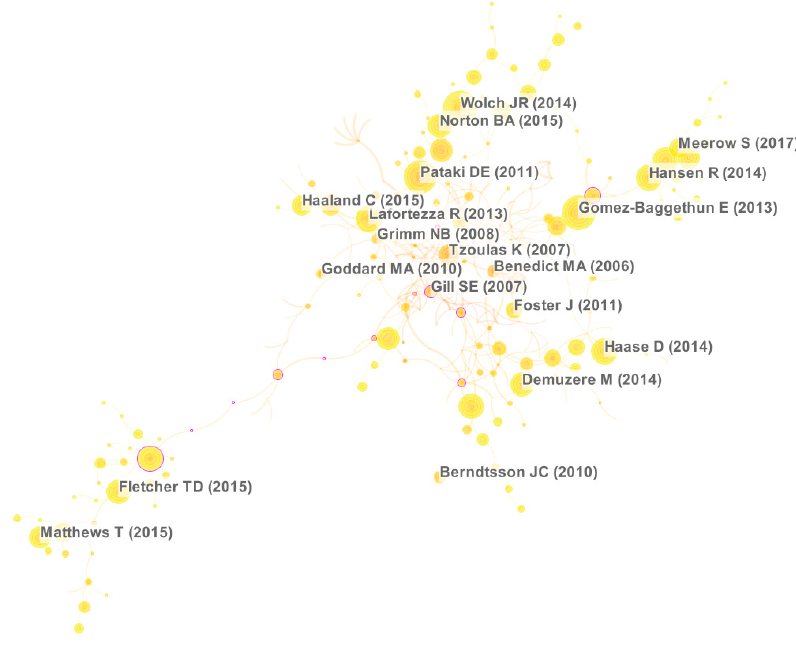
Figure 11. Co-citation of literature. Table 4. Top 10 frequently cited literature papers in the green infrastructure area.